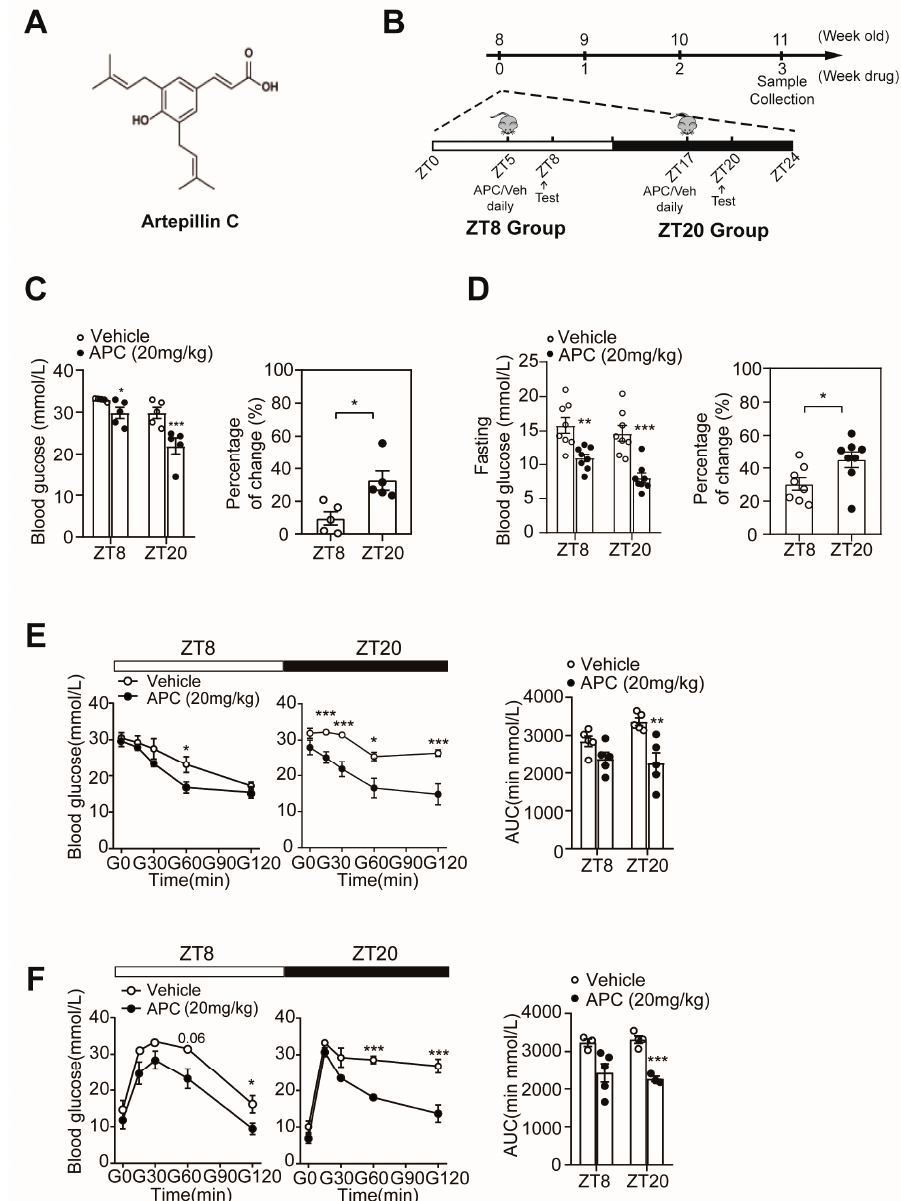
Figure 1. Circadian rhythmic impacts of APC on glucose metabolism in db/db mice: ( A ) molecular architectures of artepillin C; ( B ) schematic diagram of experimental scheme; ( C ) ad libitum blood glucose levels at ZT8 or ZT20 in db/db mice treated with 20 mg/kg APC or vehicle for 1 week ( n = 5 per group). The right panel shows the percentage change in blood glucose levels at 2 different times ZT8 and ZT20; ( D ) after fasting 16 h, the blood glucose levels at ZT8 or ZT20 in db/db mice treated with 20 mg/kg APC or vehicle for 1 week ( n = 8 per group). The right panel shows the percentage change in fasting blood glucose levels; ( E ) insulin tolerance test (ITT) and ( F ) pyruvate tolerance test (PTT) were performed around ZT8 and ZT20. The db/db mice were administrated APC (20 mg/kg) or vehicle for 2 weeks. The results of area under the curve (AUC) are shown at the bottom of each test curve ( n = 3–5 per group). * p < 0.05; ** p < 0.01; *** p <